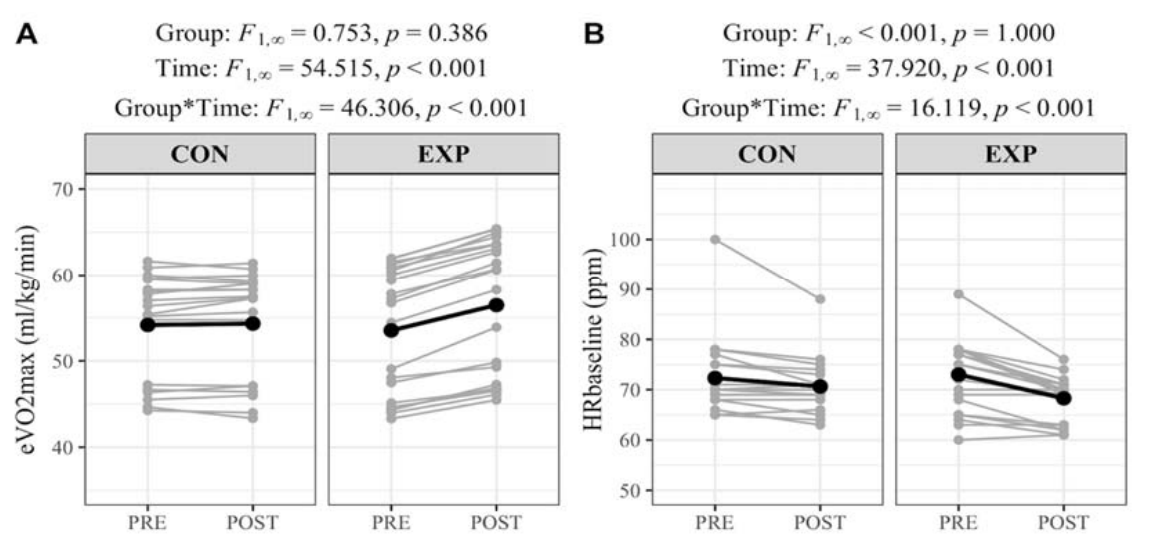
Figure 1. Individual responses and effects of fixed factors on eVO2 max and HR baseline before and after the intervention.